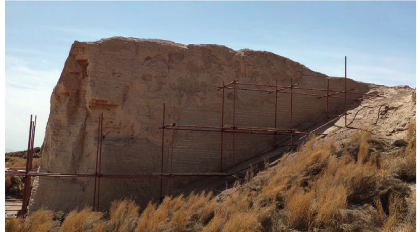
Figure 1: The reinforced site wall.